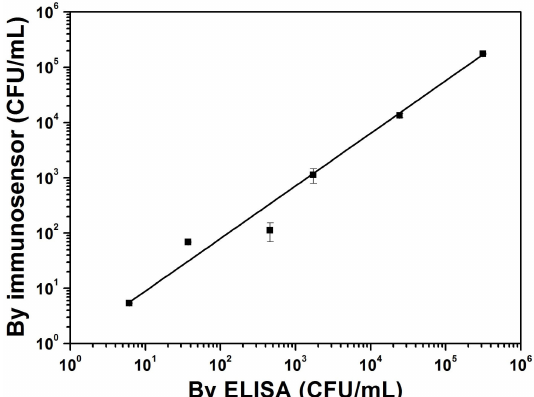
Figure 8. Comparison between the L. acidophilus cell concentrations estimated by the current L. acidophilus immunosensor and by the ELISA method for different diluted commercial drinkable yogurts. Drinkable yogurts from three different commercial brands were used to prepare the diluted samples in the cell binding buffer at low (1–10 2 CFU/mL), medium (10 2 –10 4 CFU/mL), and high (10 4 –10 6 CFU/mL) cell concentrations, respectively. The ELISA test was performed on a Falcon 96-well microplate (Corning, Corning, NY, USA) that had been directly coated with anti- L. acidophilus antibodies and blocking glycine in sequence. After the adsorption with either different diluted pure L. acidophilus cell cultures, which were used as the standards for the calibration curve, or the diluted drinkable yogurt samples, the captured cells were first identified with the primary anti- L. acidophilus antibodies and then fluorescently labelled with goat anti-rabbit IgG H&L conjugated with Alexa Fluor ® 488 (Abcam, Cambridge, UK). The ELISA signals were analyzed with a Synergy H1 Multi-Mode microplate reader (BioTek, Winooski, VT, USA). No fluorescent signal was observed for the control experiment without adding cells in the tested solution. The immunosensor data represent the average of three chips with one standard deviation. The line was obtained by fitting the data with a power-law